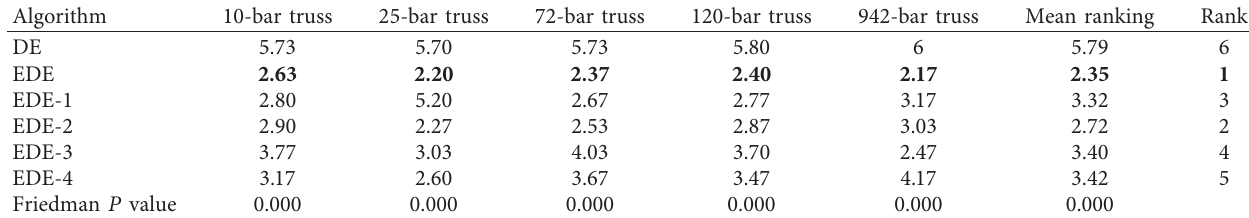
Figure 16: Convergence rates of DE, EDE, EDE-1, EDE-2, EDE-3, and EDE-4 for the 942-bar truss. Table 9: Average ranks for different algorithms across all five truss